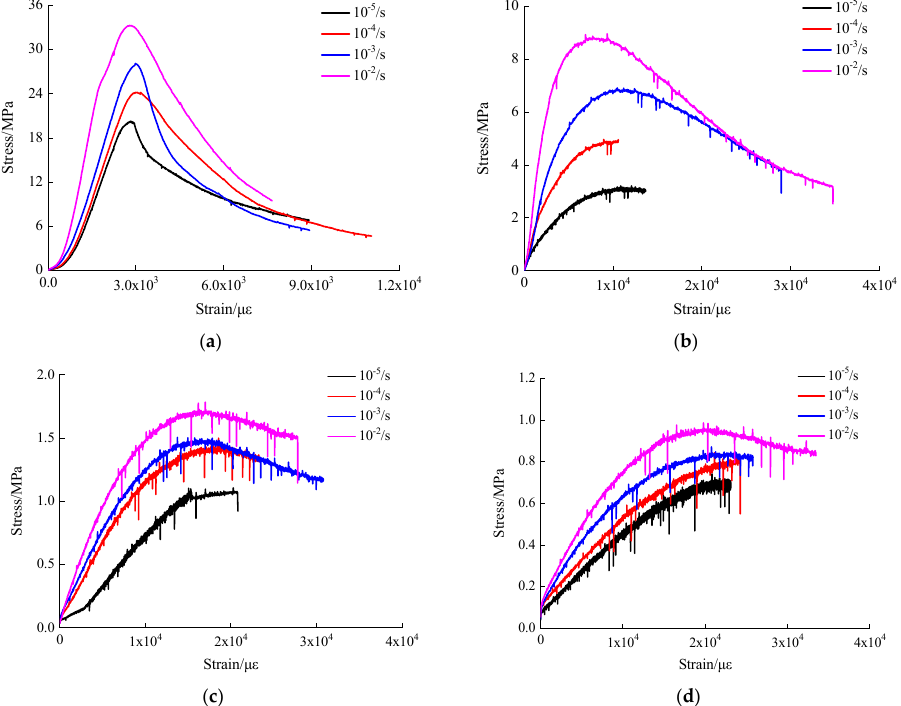
Figure 6. Stress-strain curves of hydraulic asphalt concrete under different temperatures. ( a ) Figure6. Stress-straincurvesofhydraulicasphaltconcreteunderdi ff erenttemperatures. ( a )temperature − 20 ◦ C; ( b ) temperature 0 ◦ C; ( c ) temperature 25 ◦ C; ( d ) temperature 45 ◦ C. temperature − 20 °C; ( b) temperature 0 °C; ( c ) temperature 25 °C; ( d ) temperature 45 °C.